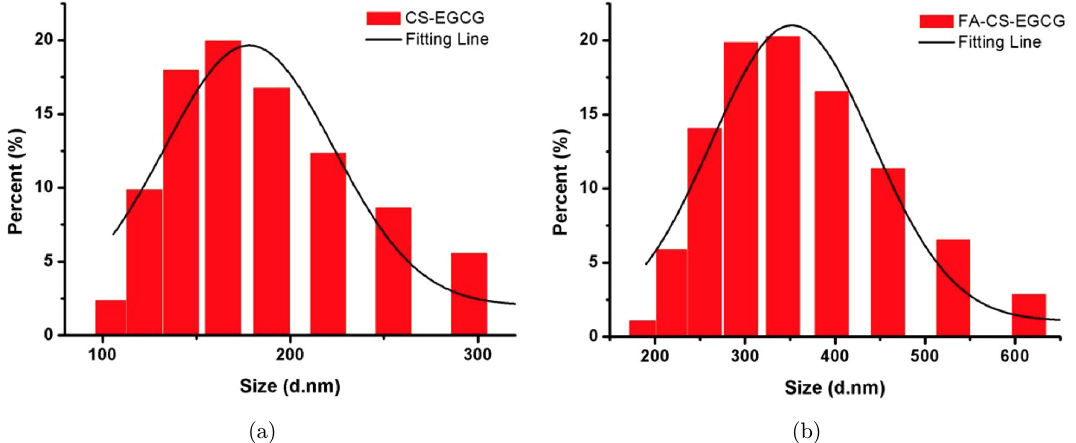
Fig. 4. Hydrodynamic size distribution of (a) CS-EGCG and (b) FA-CS-EGCG in aqueous suspension measured by dynamic light scattering (DLS).